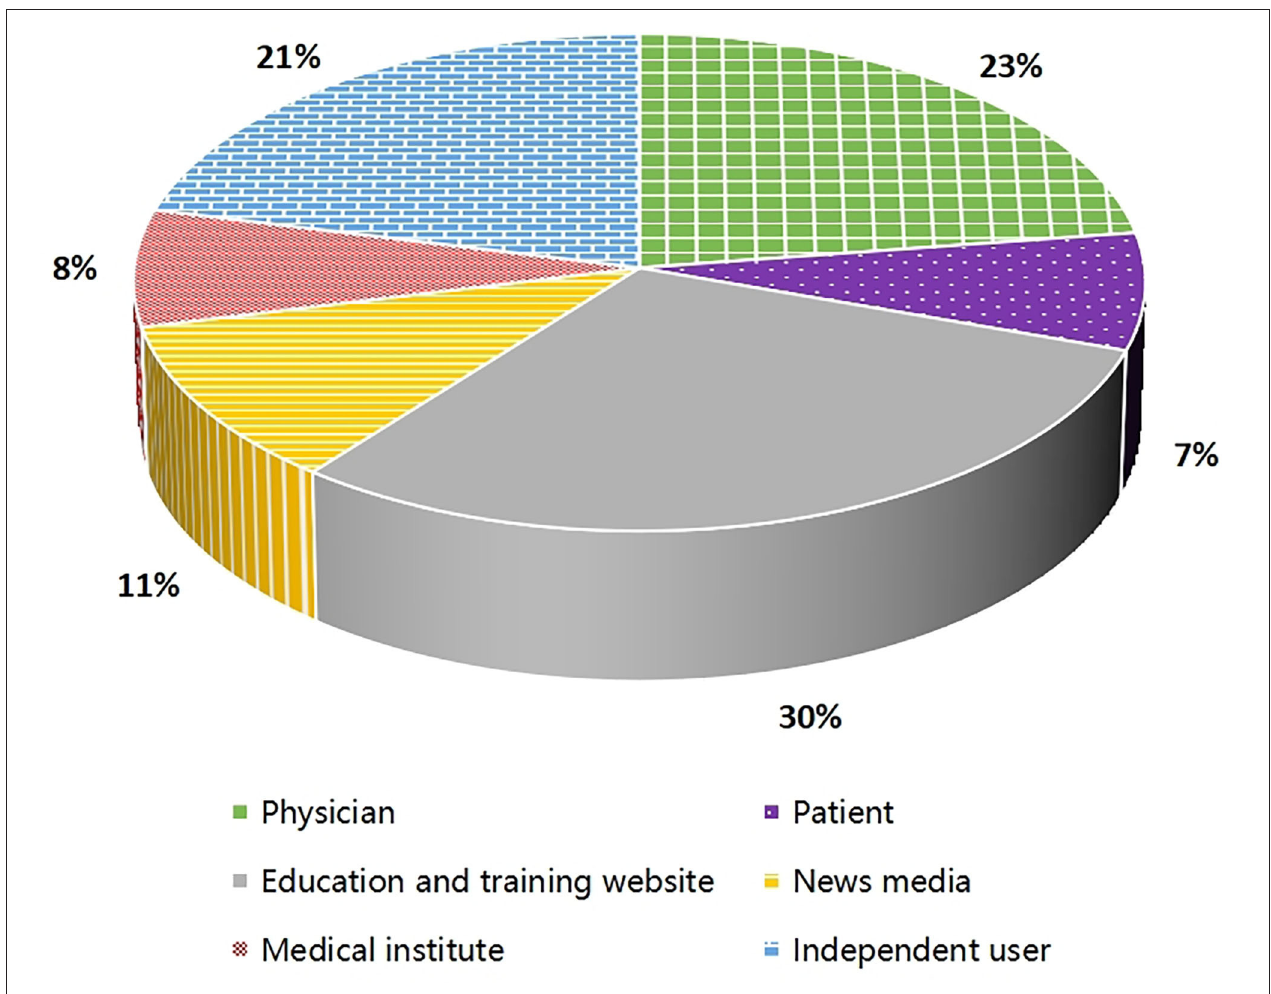
FIGURE 3 | Source of included